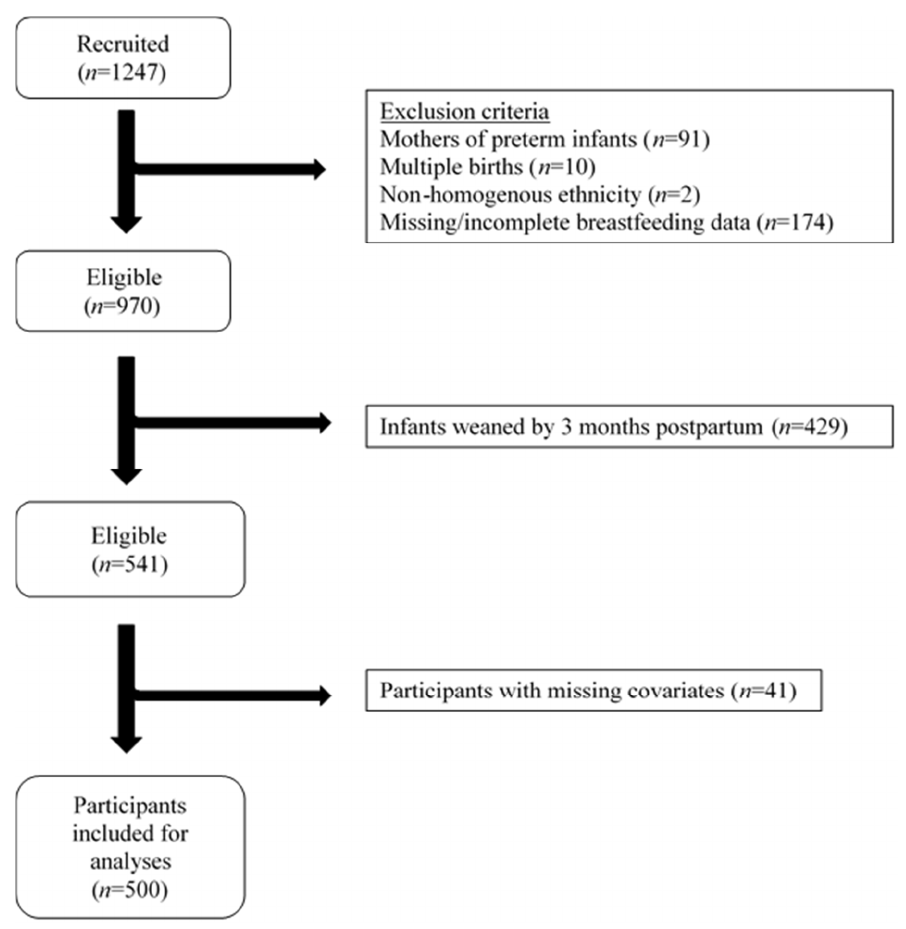
Figure 1. Flowchart of participants included for analysis in the GUSTO (Growing Up in Singapore Towards healthy Outcomes) study, Singapore.